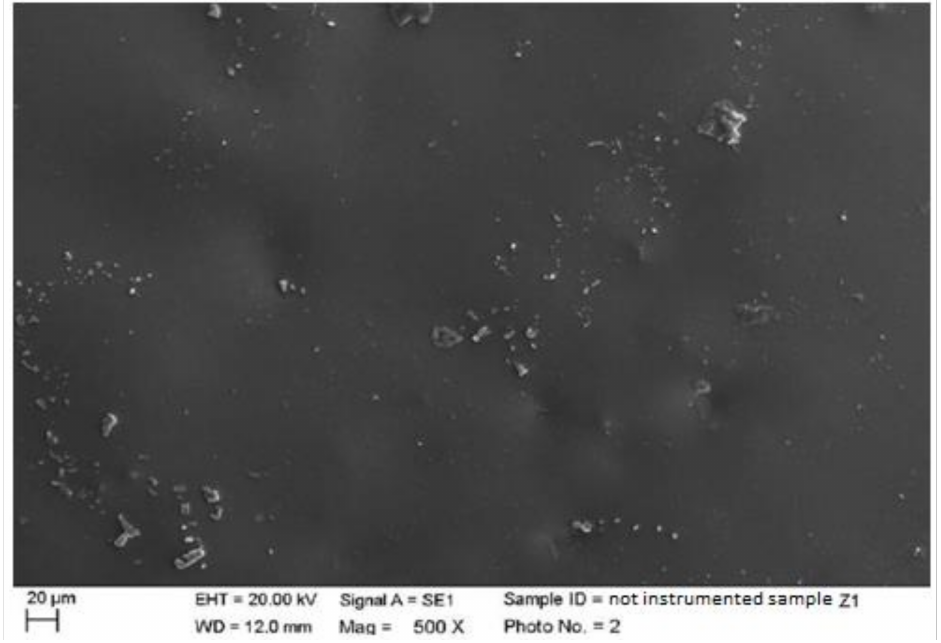
Figure 5. Non-instrumented zirconium sample Z1 (500 ×